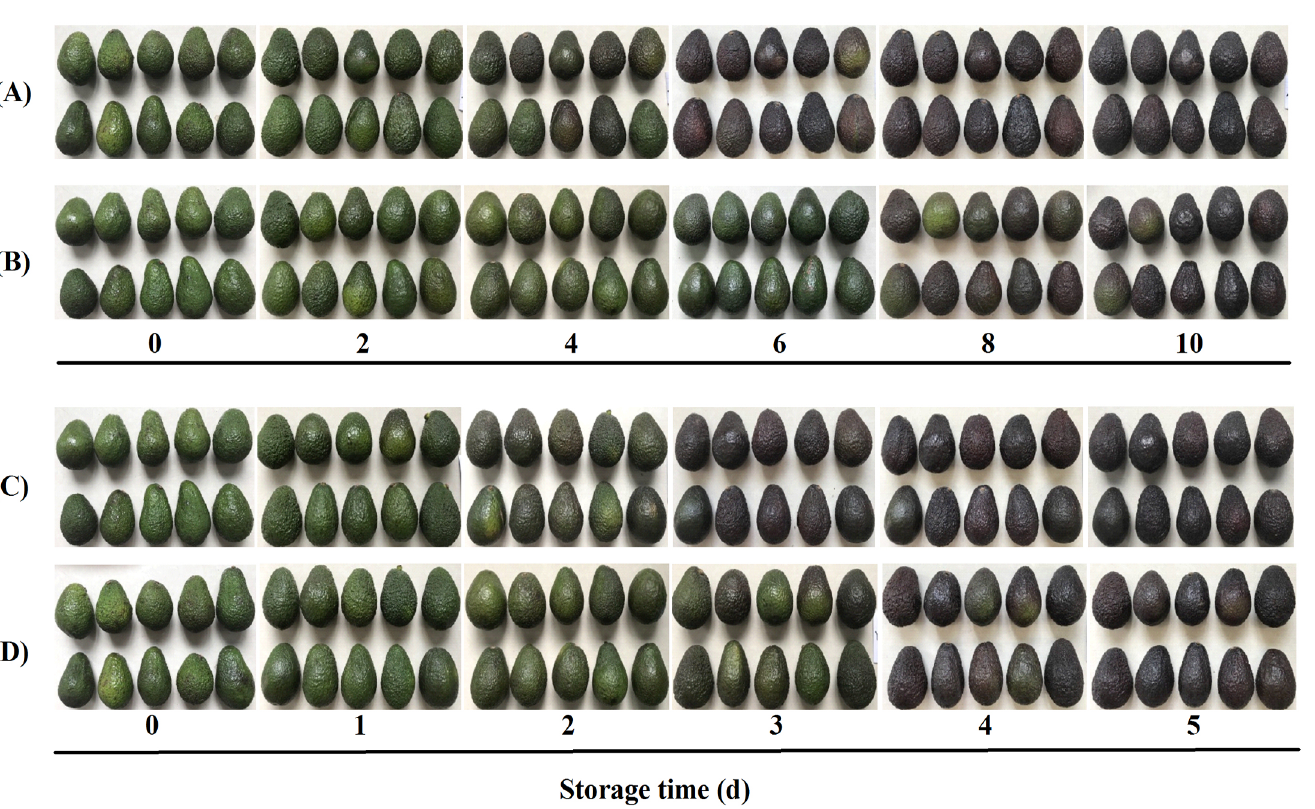
PLOS ONE | https://doi.org/10.1371/journal.pone.0189991 December18,